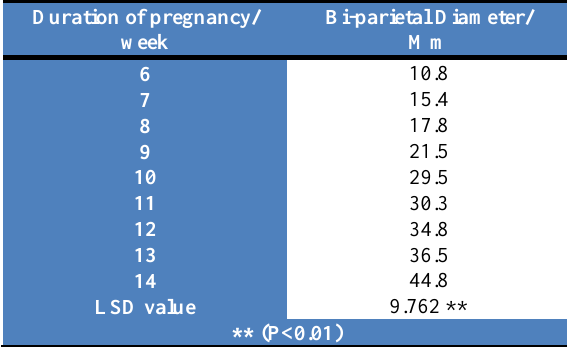
Figure, 9: Measurement of fetal BPD in 12 th week of pregnancy, indicated by straight line (Sector probe, 5MHz). Table, 2: Relationship between gestation age and BPD.